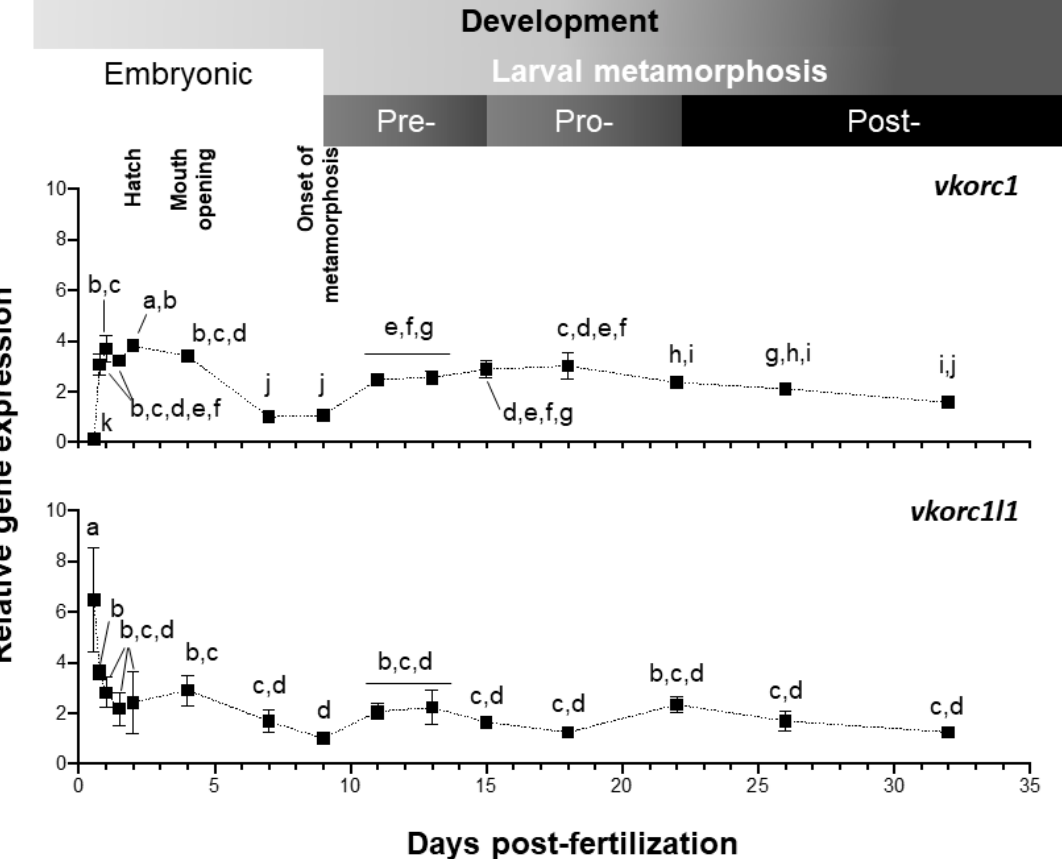
Figure 4. Relative gene expression of Senegalese sole vitamin K epoxide reductase complex subunit 1 ( ssvkorc1 ) and vkorc1 like 1 ( ssvkorc1l1 ) throughout larval development. Transcript levels of ssvkorc1 (upper image) and ssvkorc1l1 (bottom image) were determined by qPCR and normalized using ubiquitin ( ubq ) gene expression. Levels at 7 and 9 hours post-fertilization (dpf) were used as reference and set to 1 for ssvkorc1 and ssvkorc1l1 , respectively. Different letters over gene expression values denote significant differences among developmental stages (n = 3; one-way analysis of variance (ANOVA), Tukey multiple-comparison test; P < 0.05).